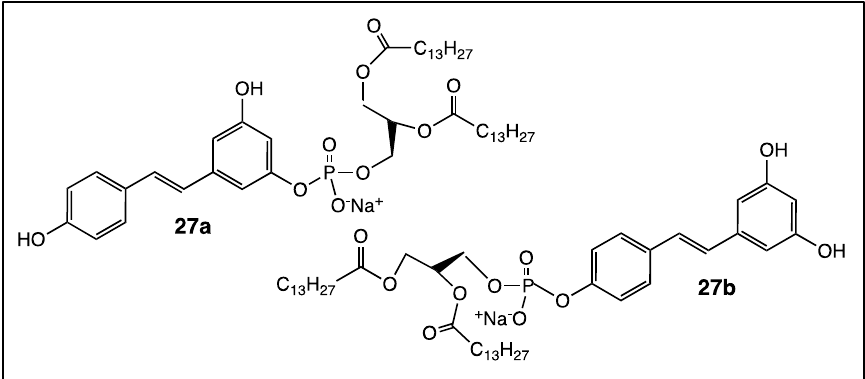
Figure 15 . Structure of resveratrol-1,2-DiMyristoyl- sn -glycero-3-Phosphoholine (DMPC) hybrid compounds 27a – b.